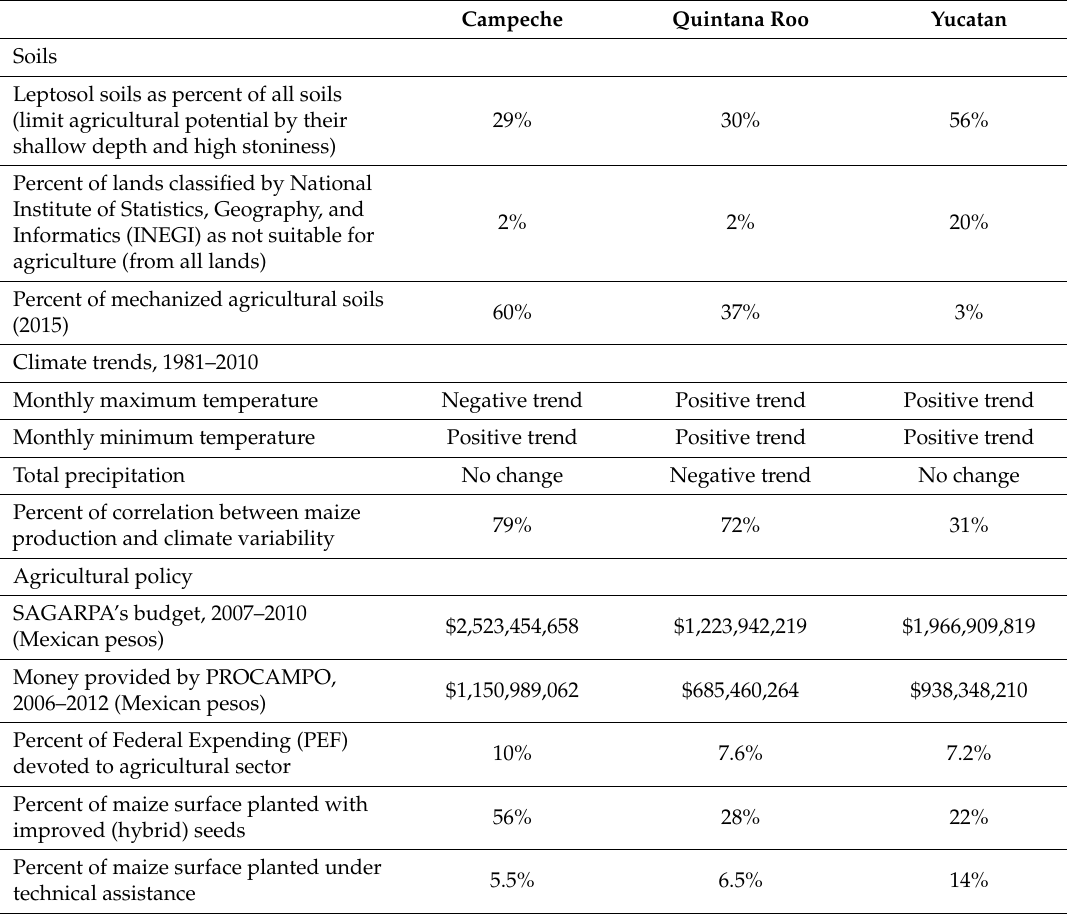
Table A2. Summary of drivers for maize production trends in Mexico’s Yucatan Peninsula. Campeche Quintana Roo